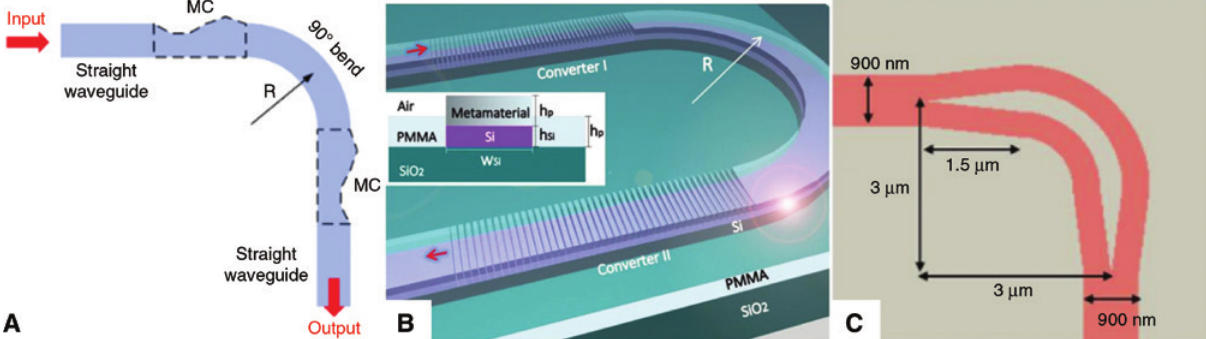
Figure 8: On-chip multimode waveguide bends based on mode converter between the straight section and the bent section. (A) A two-mode waveguide bend combining a pair of mode converters (MCs) and a 90 ° normal bend [95, 96]. (B) A sharp multimode waveguide bending assisted with metamaterial-based mode converters [97]. (C) A two-mode waveguide bend combining Y-junction-based mode converters and two single-mode arc-bends with a 4 π phase difference